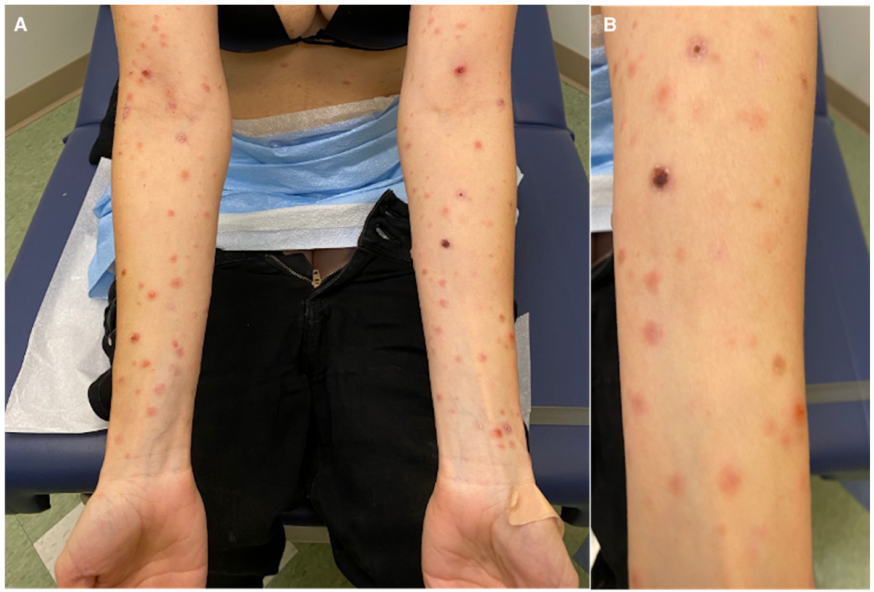
Figure 1. ( A ) Hemorrhagic crusting suggestive of PLEVA; ( B ) close-up. Multiple serial biopsies from both acute and chronic lesions were obtained. The acute lesions demonstrated spongiotic vesiculation and reticular degeneration (Figure 2A,B) while the chronic lesions exhibited more epidermal hyperplasia with overlying parakerato- sis containing neutrophils in the stratum corneum (Figure 2C,D). Changes suggestive of PLEVA, such as necrotic keratinocytes, basal layer vacuolization, extravasated red blood cells, and lymphocytic exocytosis, were present in most biopsies (Figures 2 and 3). The dermal infiltrate was predominantly composed of CD3 (+) T-lymphocytes admixed with rare CD20 (+) B-cells. In addition, a few of the biopsies also demonstrated scattered predom- inant intraepidermal CD30 (+) cells (Figure 3). A monoclonal TCR- γ gene rearrangement was also detected in one of the specimens. The histologic differential diagnosis included PLEVA and lymphomatoid papulosis (LyP).